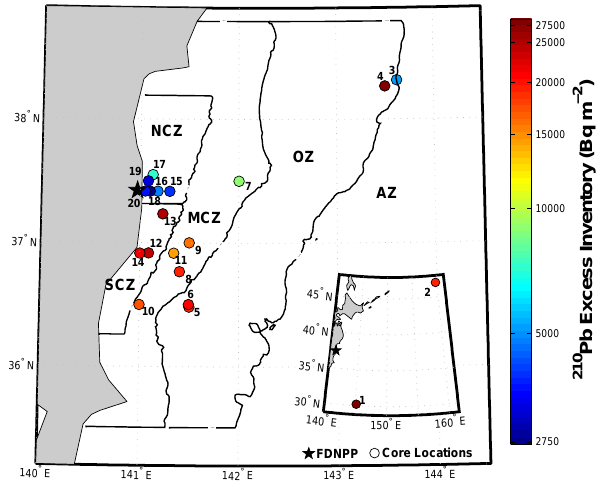
Figure 1. Core locations with 210 Pb ex inventories. Larger map: core locations 3 to 20 and the northern coastal (NCZ), southern coastal (SCZ), mid-coastal (MCZ), offshore (OZ), and abyssal (AZ) zones. Lower right: core locations 1 and 2. Some of the reported values may underestimate total inventories at the locations where 210 Pb ex continues to the core bottom (Fig.